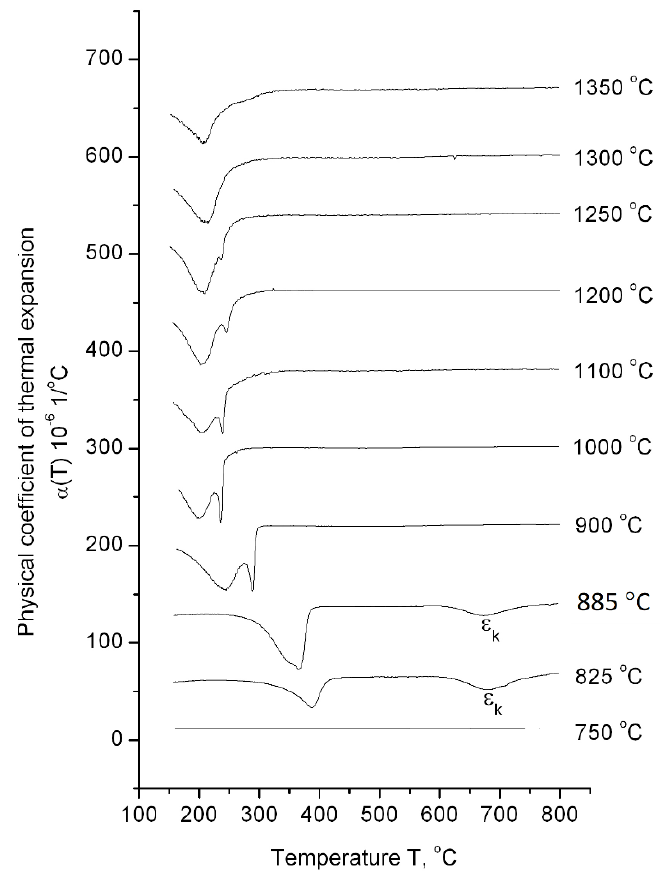
Figure 4. The effect of heating temperature on martensitic peak splitting.